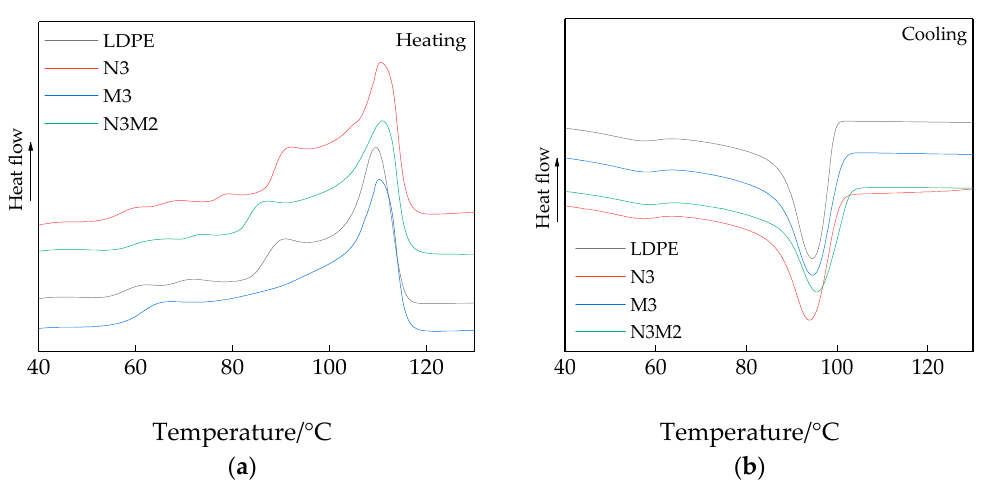
Figure 2. DSC curves of the samples: ( a ) heating curve of different samples, ( b ) cooling curves of different samples. The isothermal crystallization and melting process parameters of the samples are shown in Table 2. Table 2. Isothermal crystallization and melting process parameters of the samples. Sample